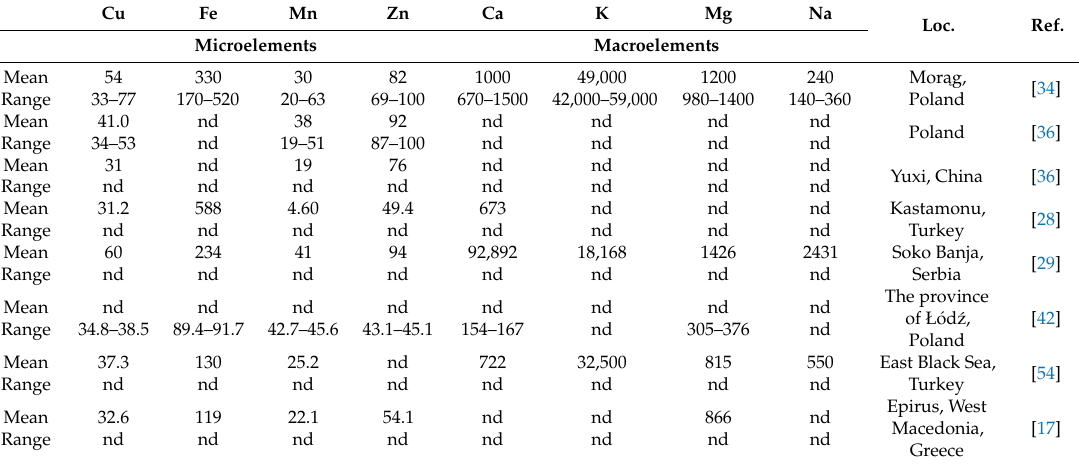
Table 5. Minerals in Cantharellus cibarius (adapted) [mg / kg d.w.]. Cu Fe Mn Zn Ca K Mg Na